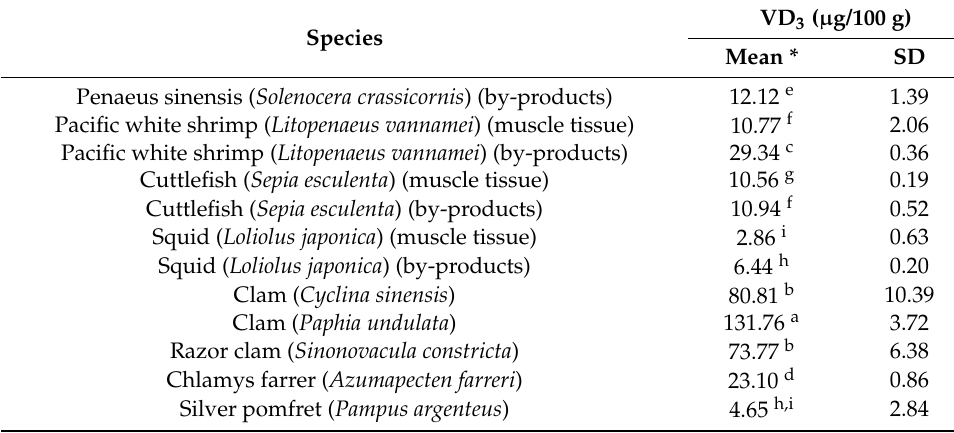
Table 2. Average content of VD 3 in the examined aquatic products.